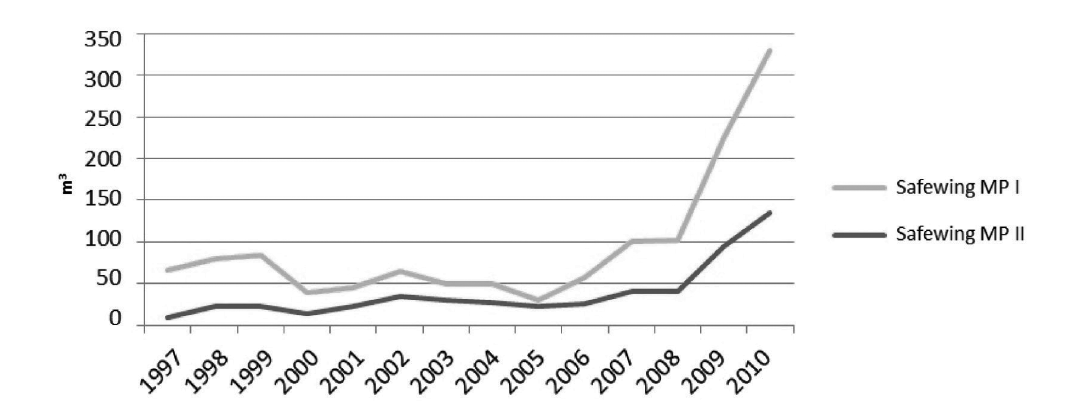
Fig. 6. Amounts of de-icing chemicals used to treat aircraft at Tallinn Airport in 1997–2010 (Keskküla